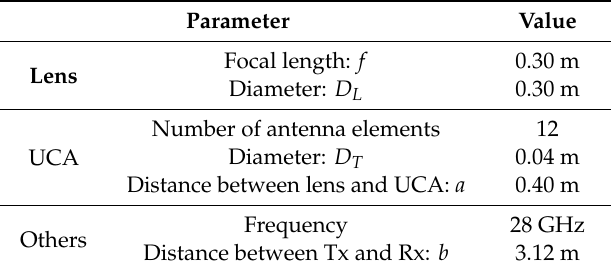
Table 1. Experimental parameters (Dielectric